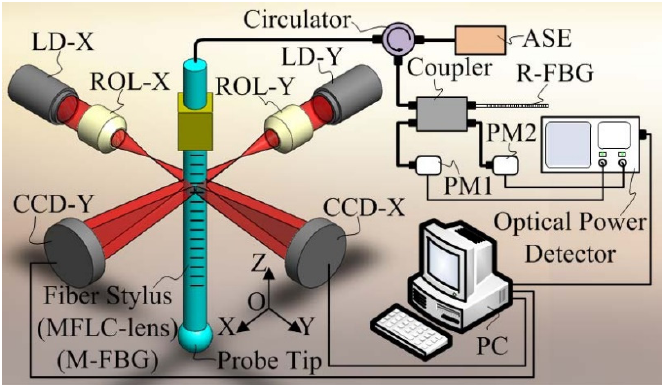
Figure 2. Schematic diagram of the 3D detection system [5].